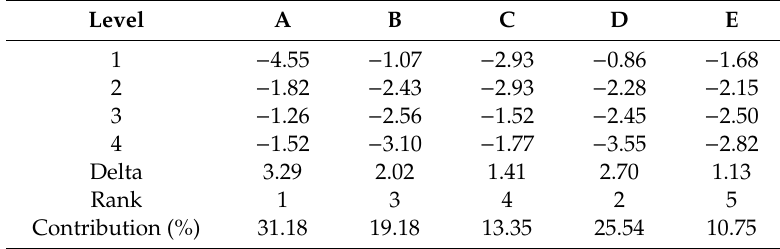
Table 5. Factorial e ff ect of h